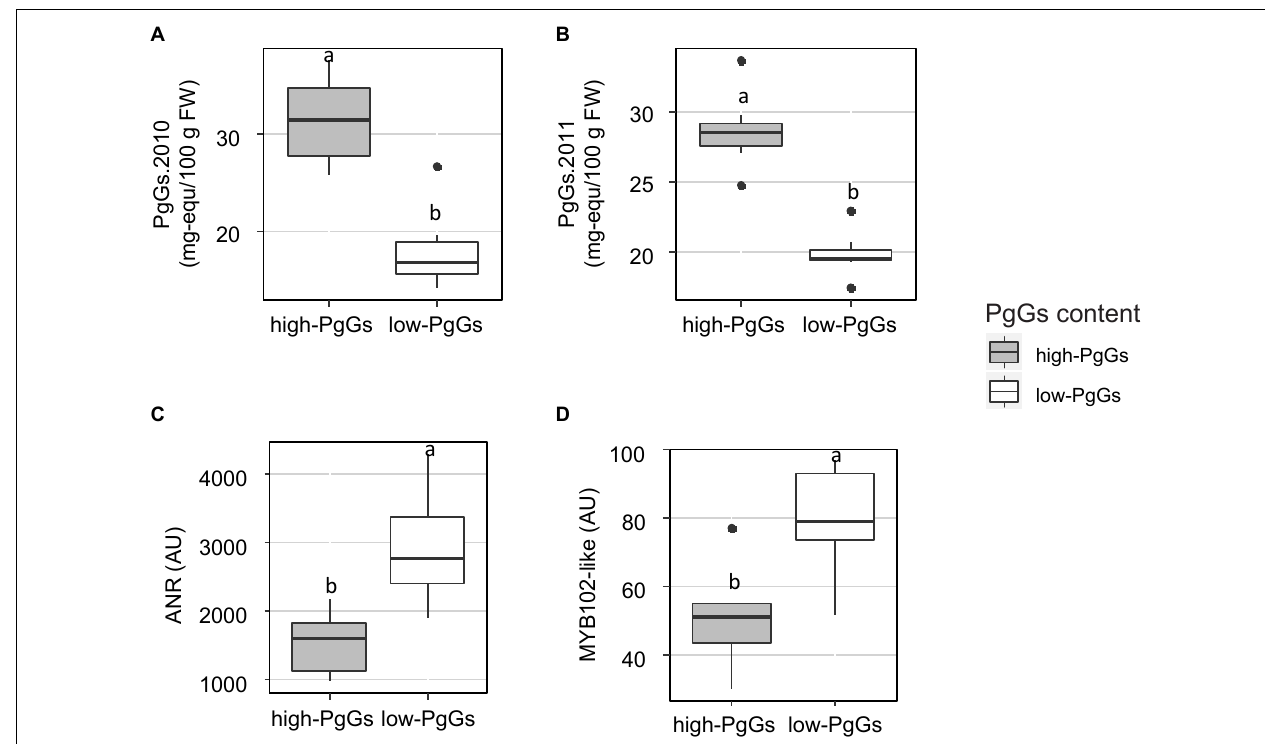
FIGURE 4 | Expression of ANR and MYB102-like ODORANT in two extreme pools of individuals with contrasted pelargonidin-3-glucoside (PgGs) content. Two pools of seven individuals from the “Capitola” and “CF1116” progeny were constituted according to their PgGs content in (A) 2010 and (B) 2011. Microarray signal values (arbitrary units) are reported for (C) ANR (FvH4_3g02980) and (D) MYB102-like ODORANT (FvH4_3g03780 ). Boxplots with different letters are significantly different (Kruskal–Wallis test, P <